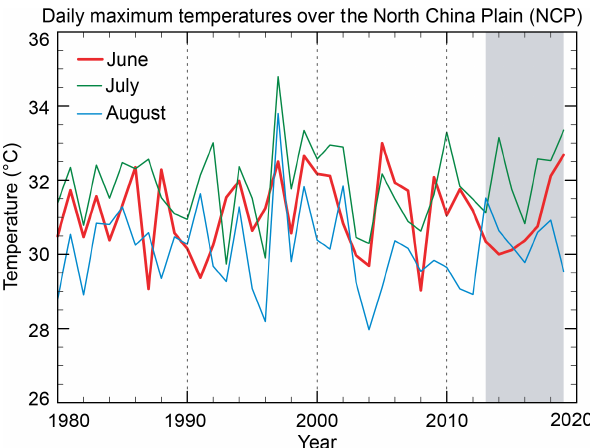
Figure 3. Summer mean trends of 850hPa wind vectors (ms − 1 a − 1 ) and surface daily maximum temperature ( ◦ Ca − 1 , shaded) over the period from 2013 to 2019. Data are from the MERRA-2 reanalysis. The trends are obtained by ordinary linear regression of mean JJA data for individual years.